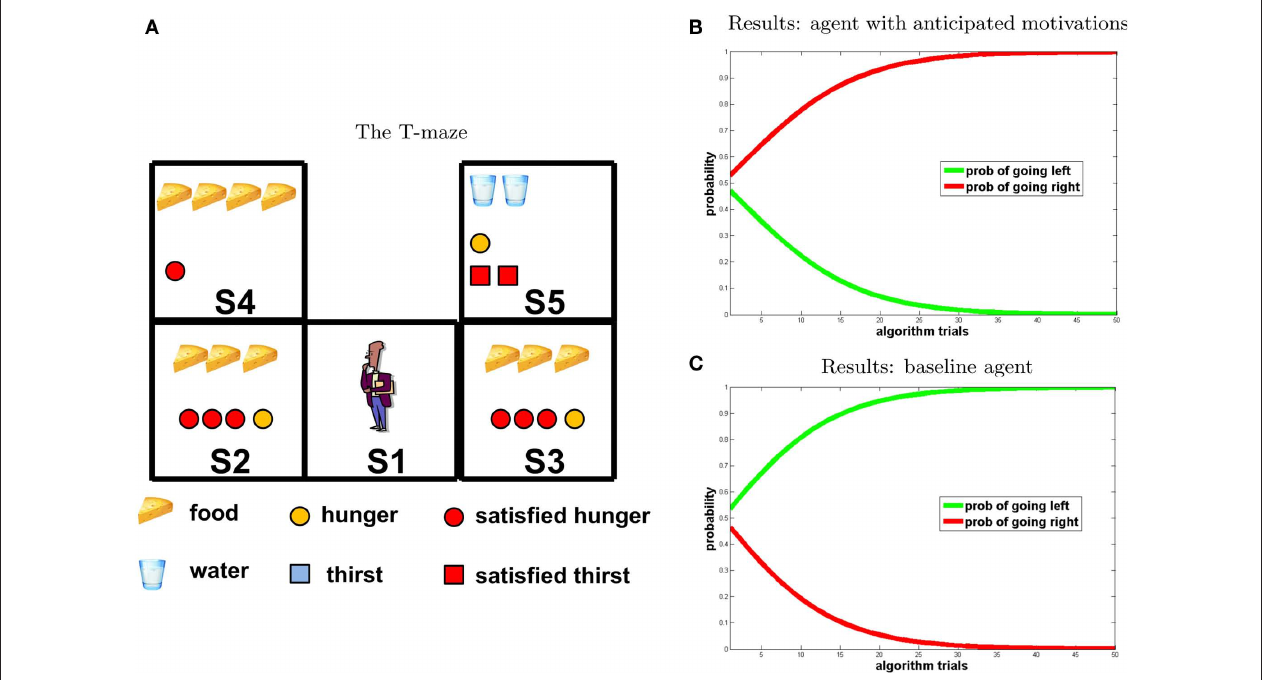
Figure 5 | experiment 2. (A) T-maze. (B,C) Results [ (A) agent with anticipated motivations; (B) baseline model], “going right” = red; “going left” =